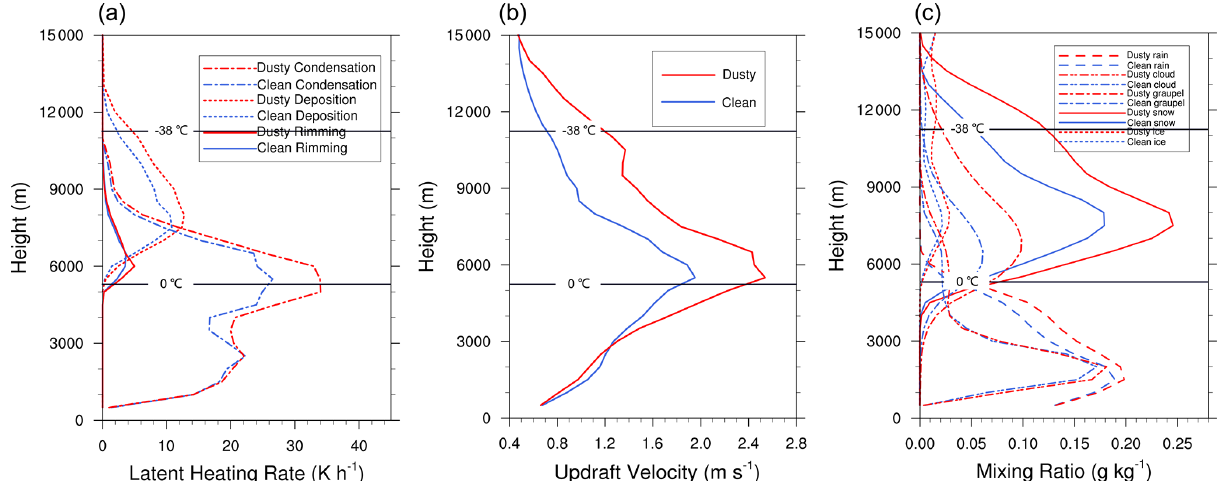
Figure 11. Vertical profiles of (a) latent heating rates and (b) vertical velocities averaged over the top 10th percentiles of the updrafts (90th to 100th, with w (cid:38) 0.5ms − 1 ) in High-Pcp area during P2 (12:00–16:00LT) from Morr2-ec-Clean (blue lines) and Morr2-ec-Dusty (red lines). (c) Vertical profiles of cloud hydrometer mixing ratios averaged among precipitation grids in the High-Pcp area during P2 simulated by Morr2-ec-Clean (blue lines) and Morr2-ec-Dusty (red